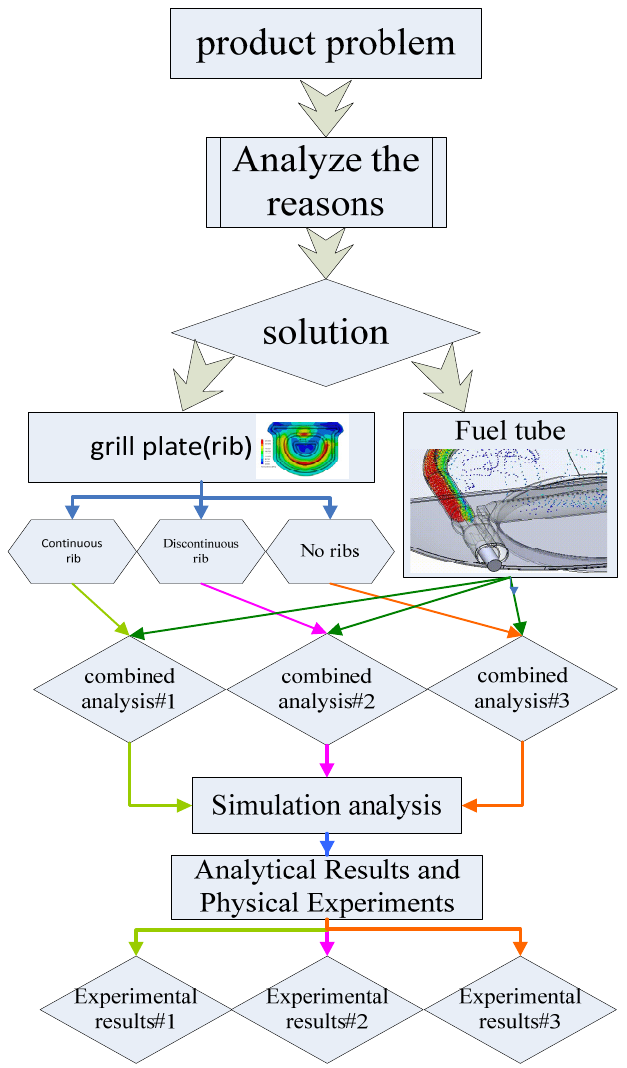
Figure 2. Research process flow.